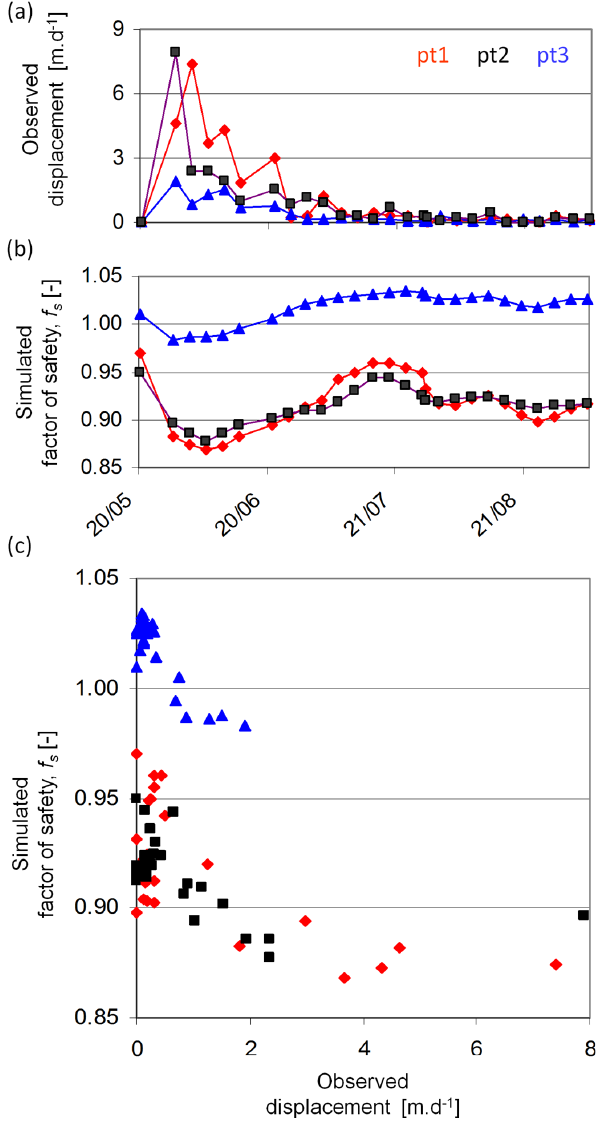
Fig. 9. (a) Observed displacement rates for points pt1, pt2 and pt3 (Travelletti et al., 2012); (b) the factor of safety, f s , simulated with additional adjustment of “snow pack/snow melt” model; (c) the re- lationship between the “new” f s and observed displacement rates (Travelletti et al., 2012). For the location of the points see Fig.